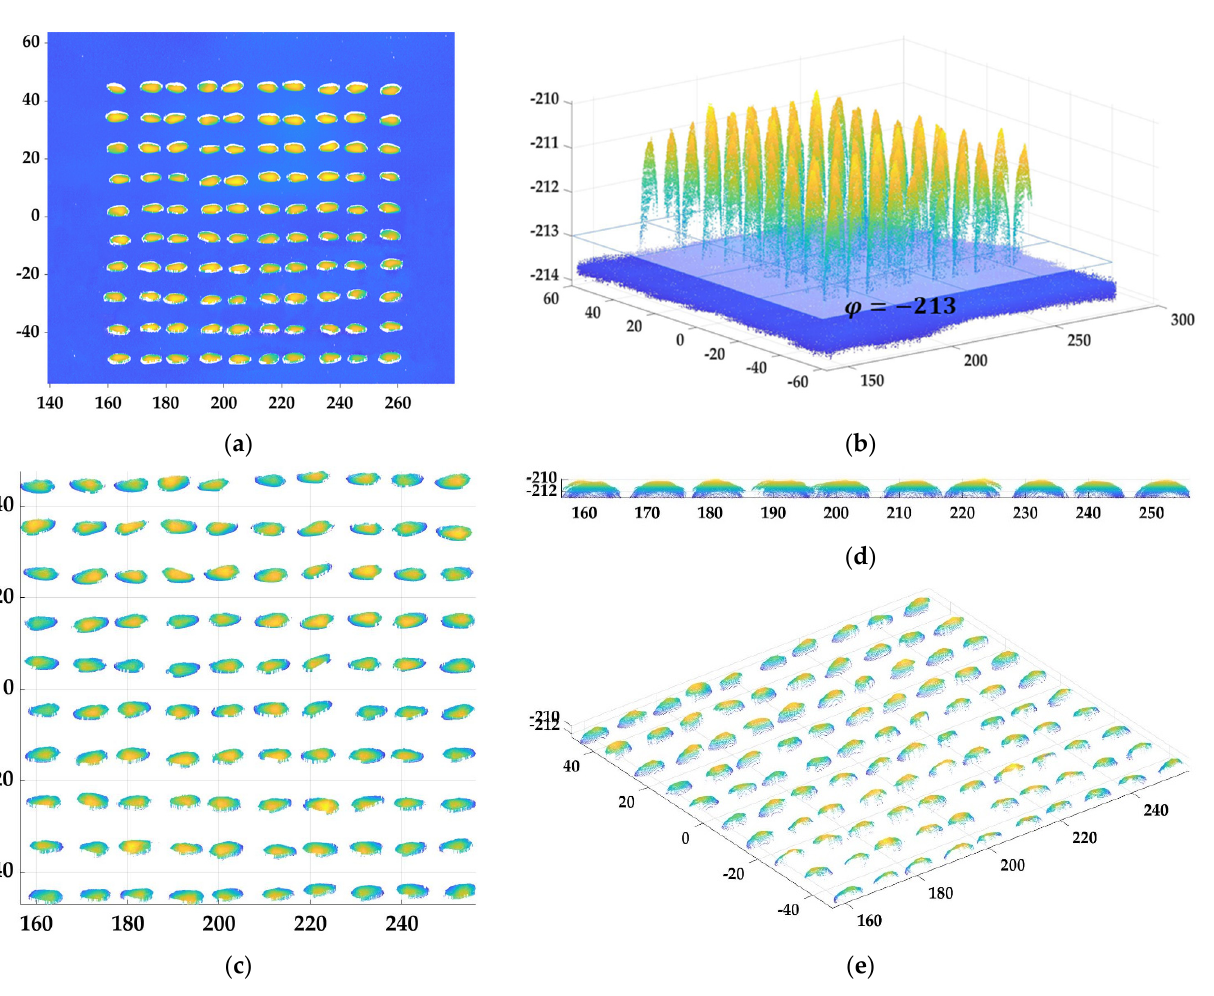
Figure 5. Grain point-cloud data extraction. ( a ) Top view of the original 3D point cloud; ( b ) northeast view of the grain and carrier point − cloud data segmentation; ( c ) top view of the extracted grain point cloud; ( d ) right view of the extracted grain point cloud; ( e ) northeast view of the extracted grain point cloud.